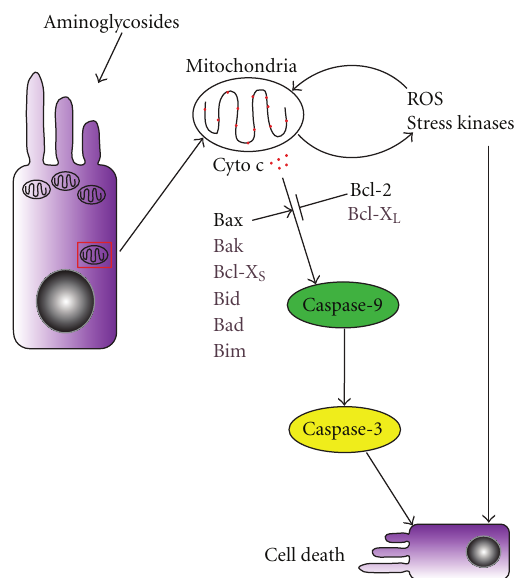
Figure 2: A simplified schematic of the cell death cascade in hair cells damaged by aminoglycosides. Reactive oxygen species (ROS), stress kinases, and the caspase family of proteases are activated and mediate hair cell degeneration caused by aminoglycoside exposure, whereas overexpression of Bcl-2 protects against caspase activation and hair cell loss. Aminoglycosides damage the mitochondria and can result in generation of ROS and activation of stress kinases. Both ROS and stress kinases can cause cell death directly as well as amplify insults targeting the mitochondria. The balance between pro-apoptotic and anti-apoptotic Bcl-2 family members determines the integrity of the mitochondria. Cytochrome c leaking out of damaged mitochondria leads to caspase-9 activation, which in turn activates caspase-3 to execute cell